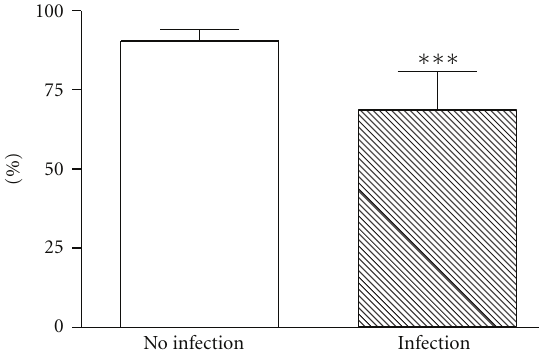
F 3: Comparison of continuous �ow between the no infection (mean � 90 [56–81]) in all vessels seen on images recorded at the ear conch. e difference is highly signi�cant (